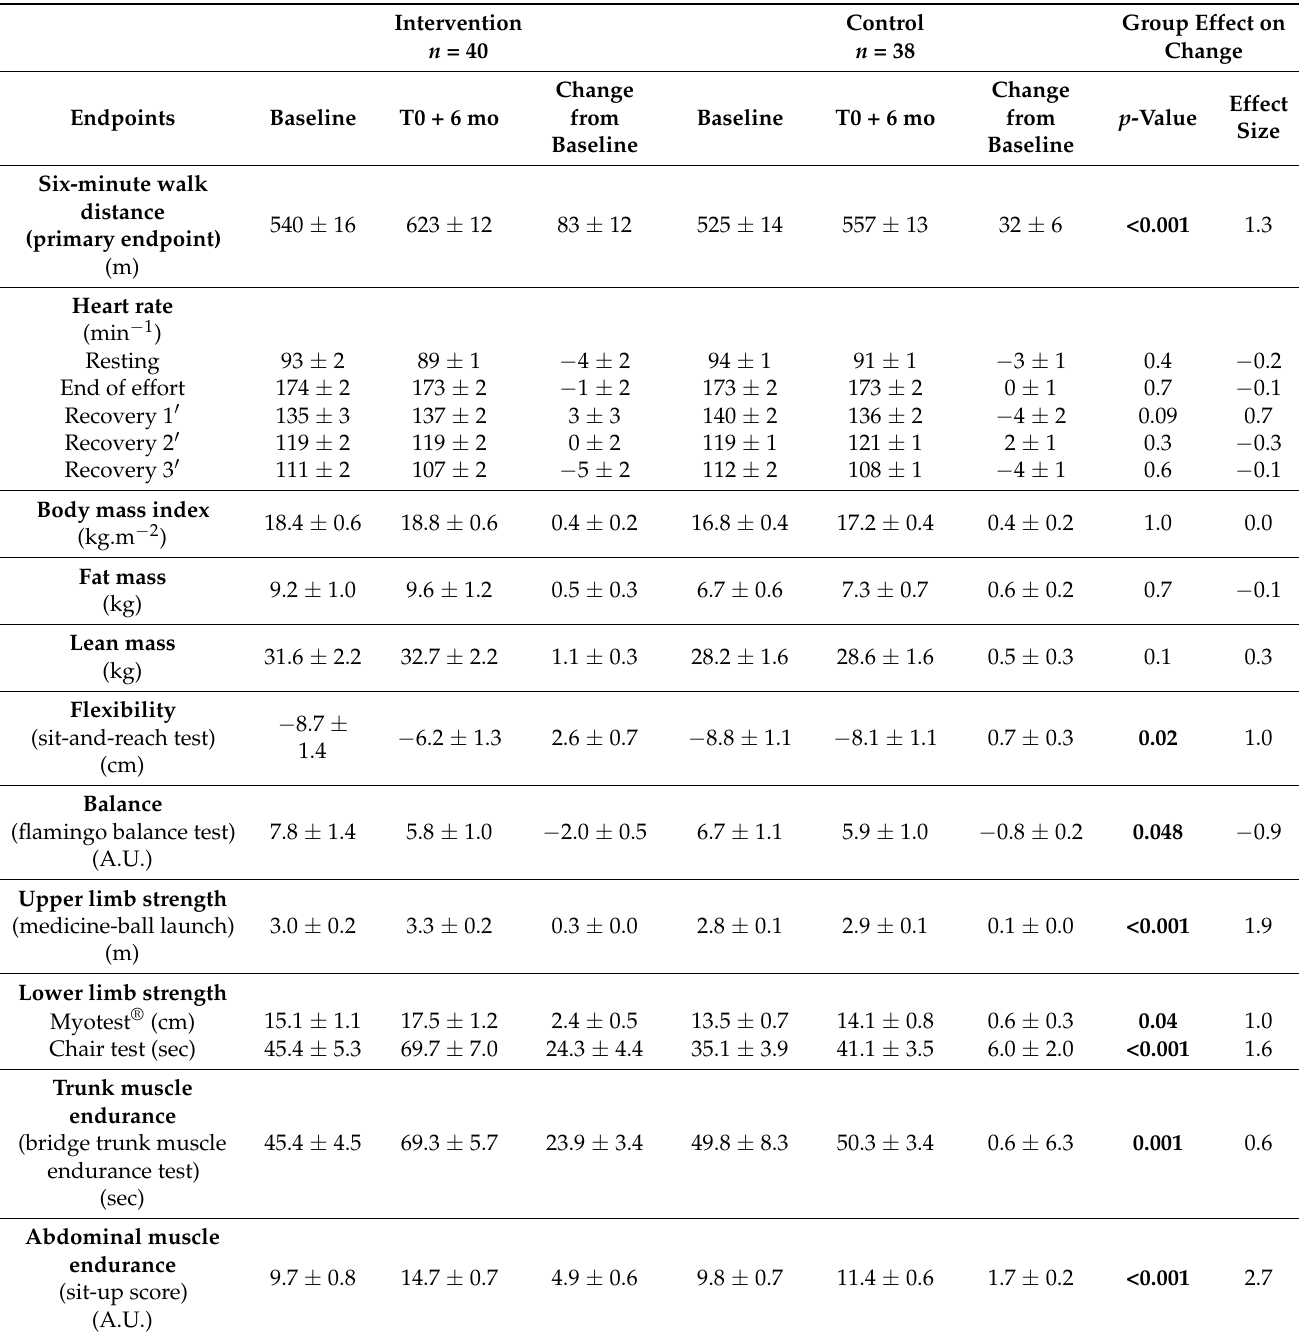
Table 2. Physical endpoints at six